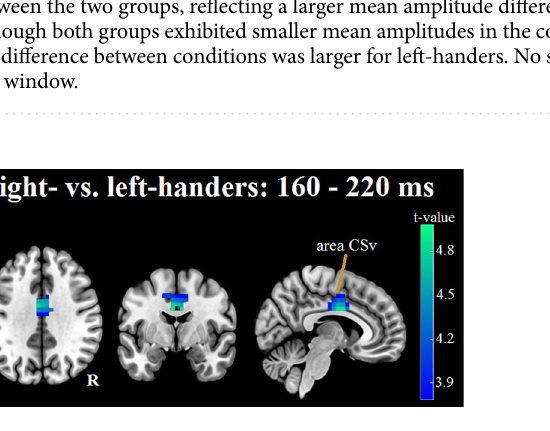
Right‑handers, late window. Again similar to the left-handers, the largest cluster showing condition differences was centrally located, with effects spreading into fronto-central and parietal electrodes (Fig. 2b). A smaller mean amplitude was observed across the cluster in the coherent condition. The source localization analysis revealed significant condition differences in estimated source activity in bilateral posterior cingulate gyrus/retrosplenial cortex/precuneus, right superior parietal lobule, left precentral gyrus, left postcentral gyrus, and left parieto- operculum/insular cortex (Fig. 4b). The maximum difference was located in the precuneus. Right‑handers versus left‑handers. Differences between left- and right-handers were examined by comparing the coherent minus incoherent mean amplitude difference between the two groups. Again, signifi- cant differences were assessed by means of cluster-based permutation tests in the early and late windows and the largest clusters exceeding a threshold of p < 0.01 are reported.